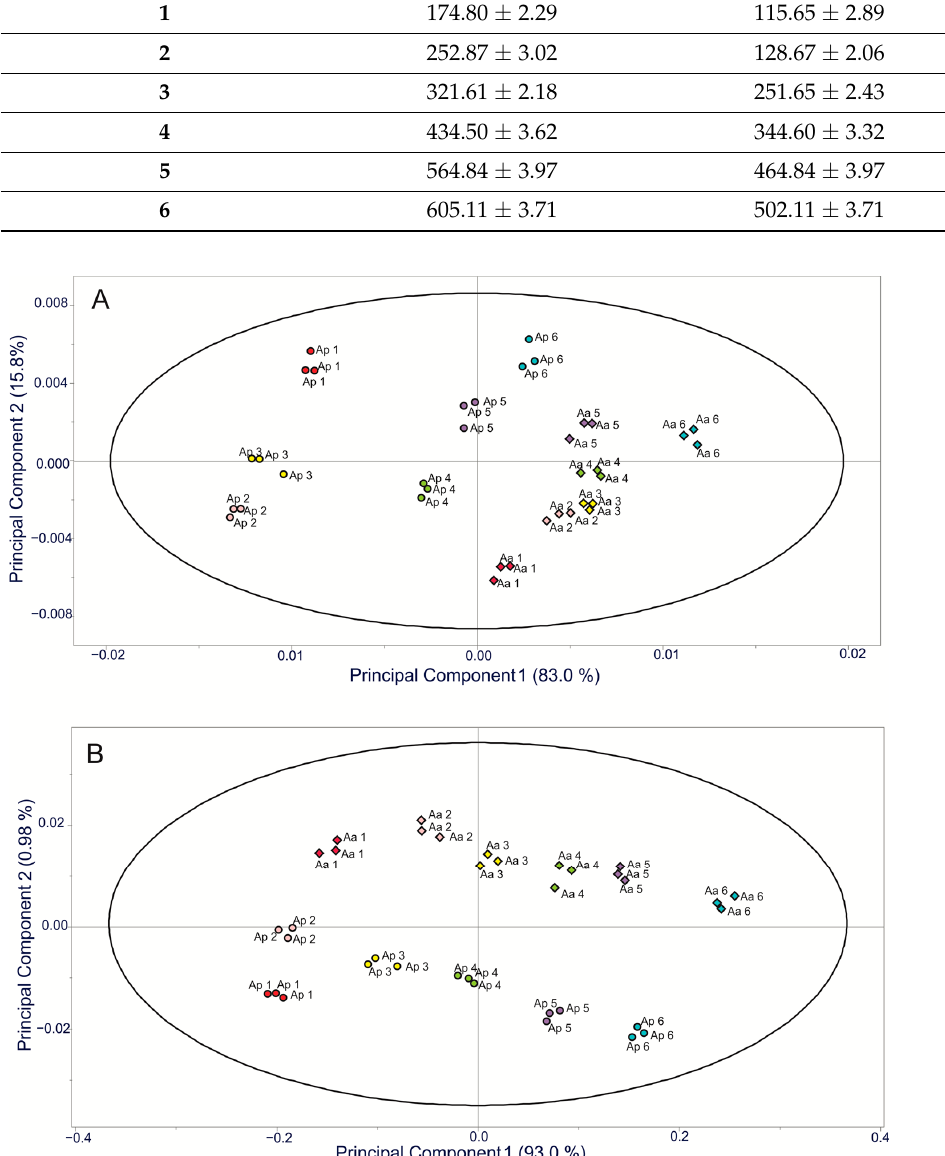
Figure 5. Principal component analysis (PCA) models for FT-IR spectra of agave fructans from A. angustifolia and A. potatorum plants of different ages. ( A ) Carbohydrate region (1300–900 cm − 1 ); ( B ) fructan region (950–920 cm − 1 ).